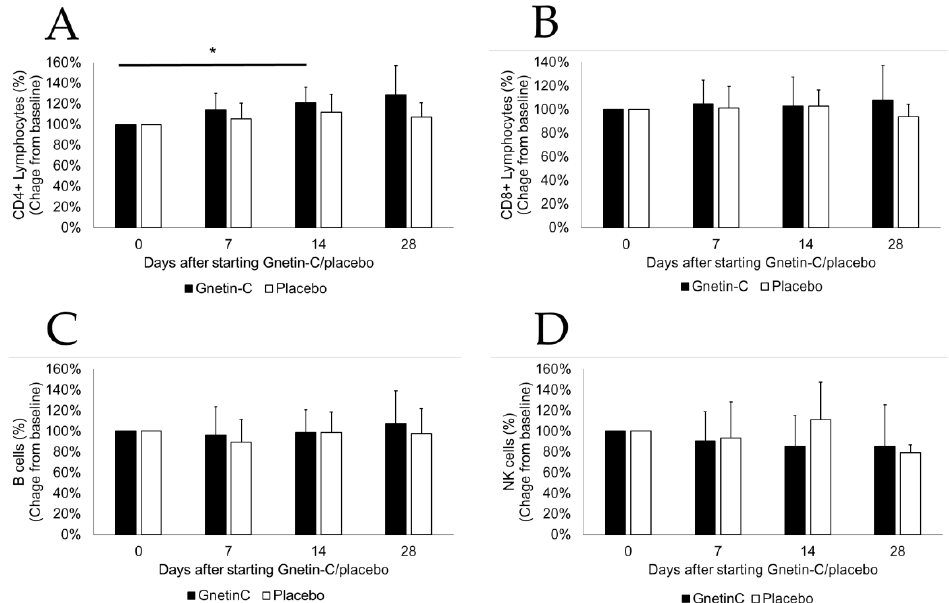
Figure 4. The effects of Gnetin-C on circulating peripheral blood mononuclear cells (PBMCs) were examined by flow cytometry. The administration of Gnetin-C resulted in a significant increase in the ( A ) CD4 + T cell population; ( B ) Regarding other circulating lymphocytes, including CD8 + T cells; ( C ) CD20 + B cells, and ( D ) NK cells, no marked changes were noted. * p < 0.05.